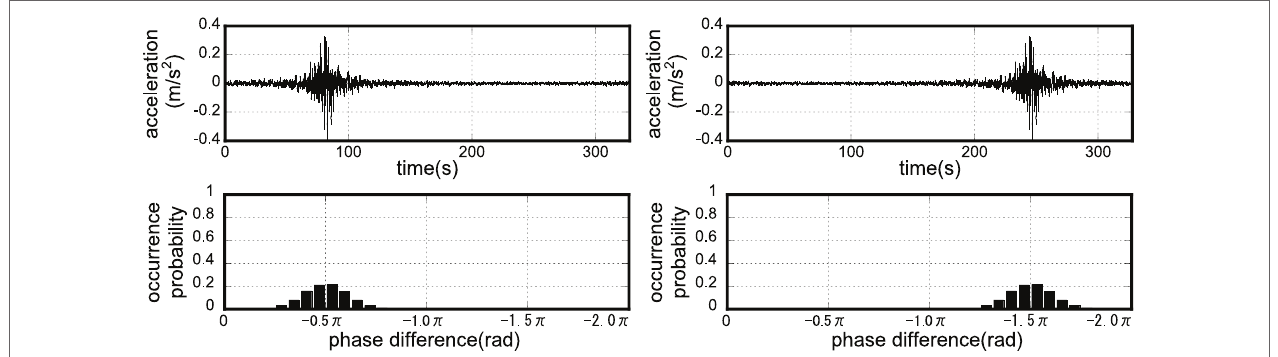
FIGURE 3 | Accelerograms and distributions of phase difference with different means of phase difference (cid:0) 0.5 π , (cid:0) 1.5 π .